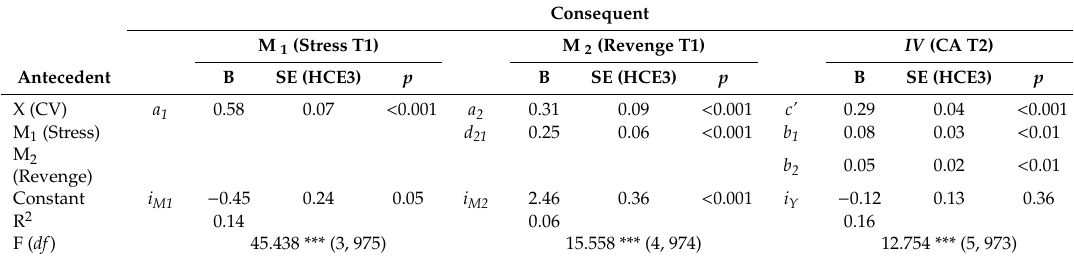
Figure 3. Results of serial multiple mediating test (Model 6) for stress and avoidance as mediators. Coe ffi cients are unstandardized. The dotted lines indicate nonsignificant pathways. *** p < 0.001. Table 3. Regression coe ffi cients, standard errors, and model summary information for stress and avoidance as